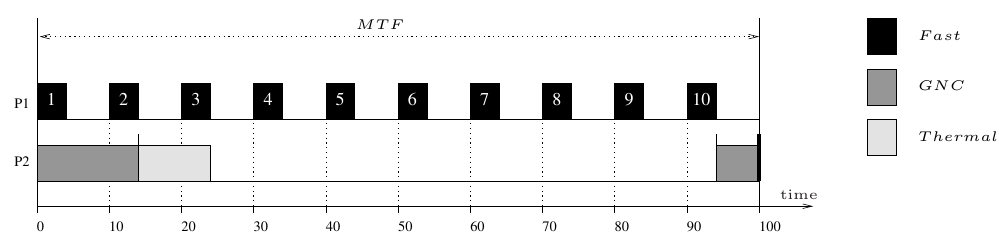
Figure 11 Scheduling result for the example in Figure 7 on a two-processor architecture with zero communication